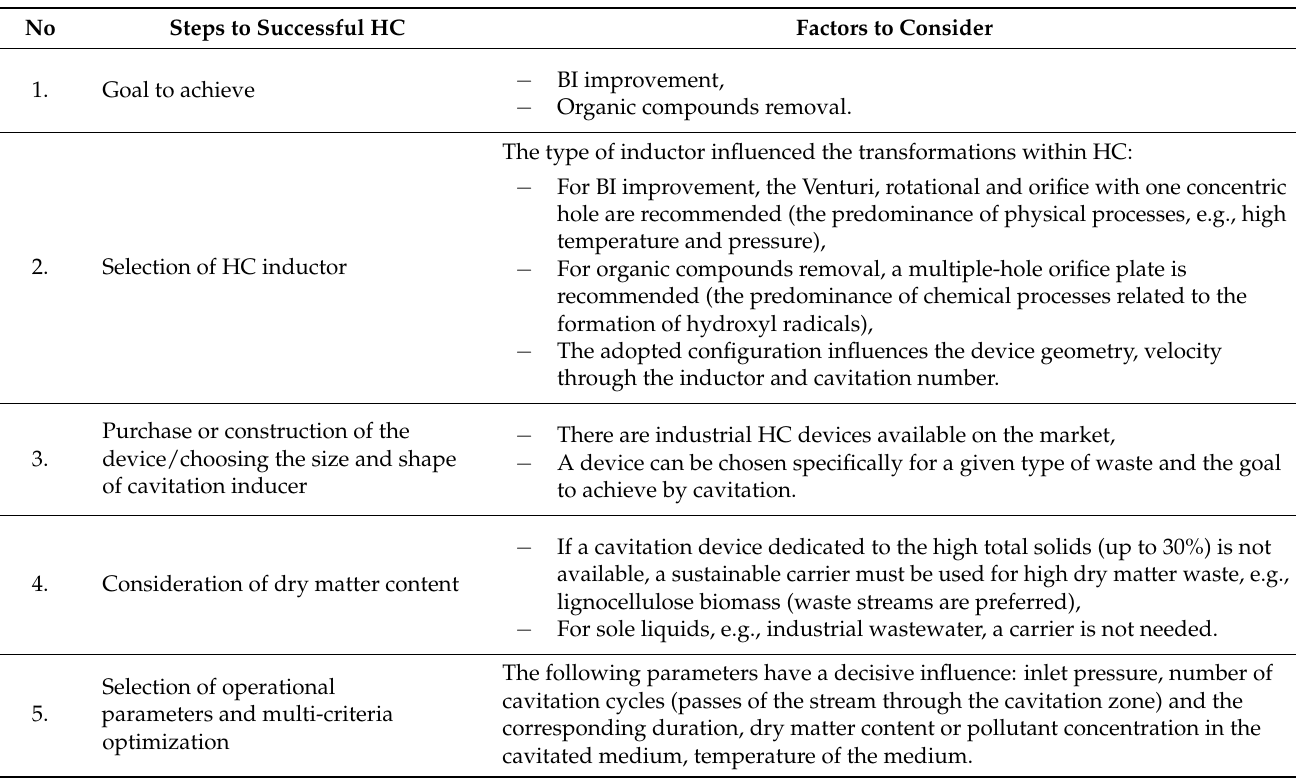
Table 4. Challenges of hydrodynamic cavitation of organic